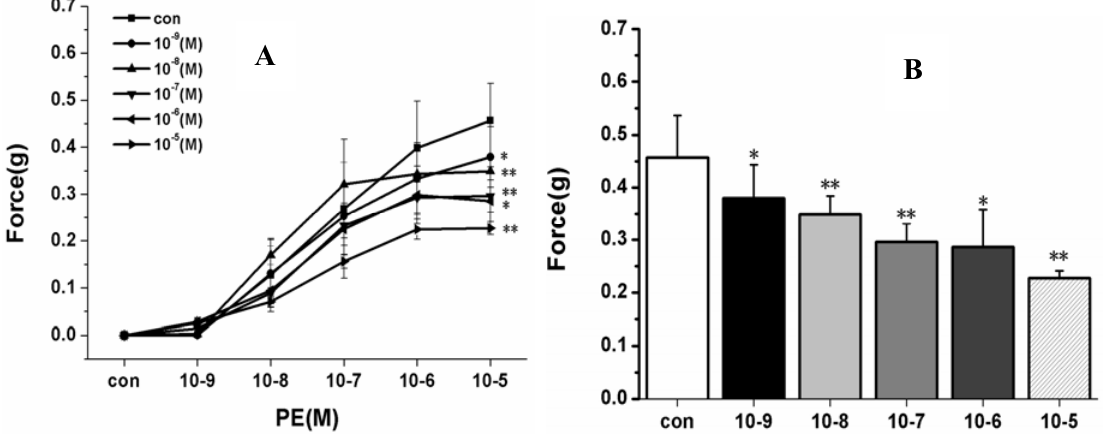
Figure 4. Vascular effect of HSYA on PE-induced constriction in rat PA rings with different concentration (10 − 9 M–10 − 5 M). * p < 0.05 compared with control; ** p < 0.01 compared with